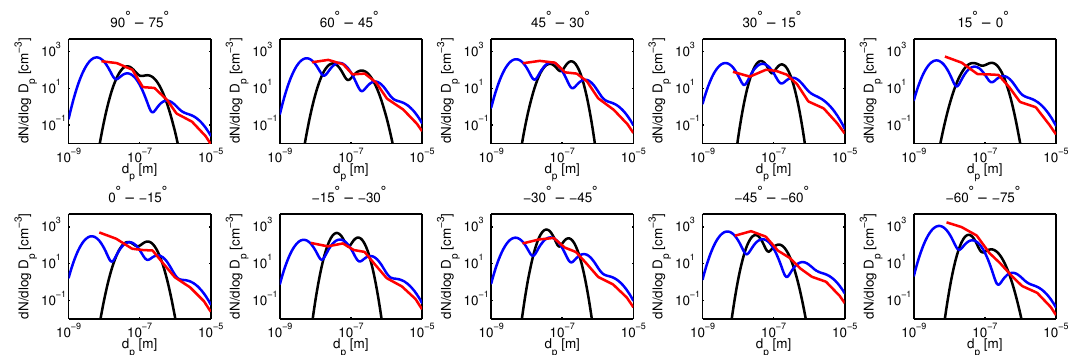
Fig. 8. Annual mean surface size distributions on twelve 15 ◦ latitude bands for SALSA (red), M7 (blue) and observations (black) collected by Heintzenberg et al. (2000). Model size distributions have been calculated in the grid points corresponding to the locations of the observations.